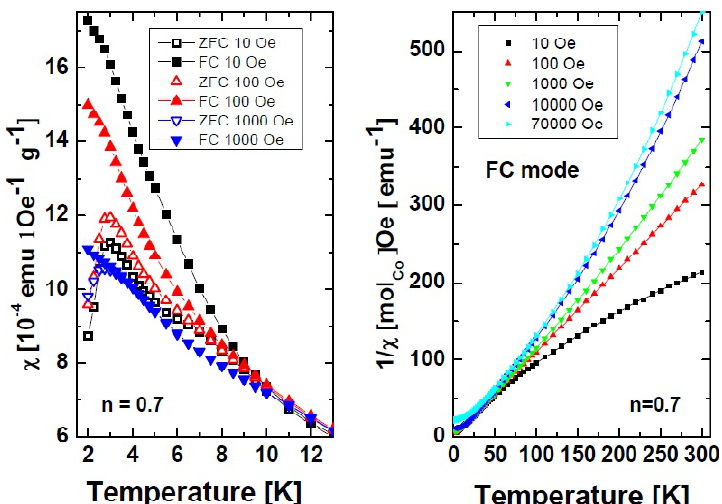
Fig. 6. (Left panel) Temperature dependence of the dc magnetic susceptibility  ( T ) in the low temperature range for n = 0.70 sample in ZFC and FC modes in external magnetic fields H = 10, 100, and 1000 Oe. (Right panel) Temperature dependence of the inverse magnetic susceptibility  -1 (T) for n = 0.70 samples in FC mode in five different external magnetic